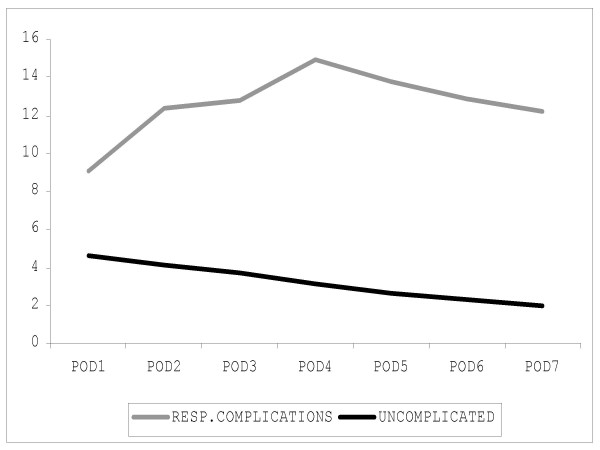
Patients developing respiratory complications (n = 60) showed a progressive increase of the mean FLAM score compared to uncomplicated patients (n = 240), who had a progressively descending FLAM. The difference was significant for all the 7 postoperative days.